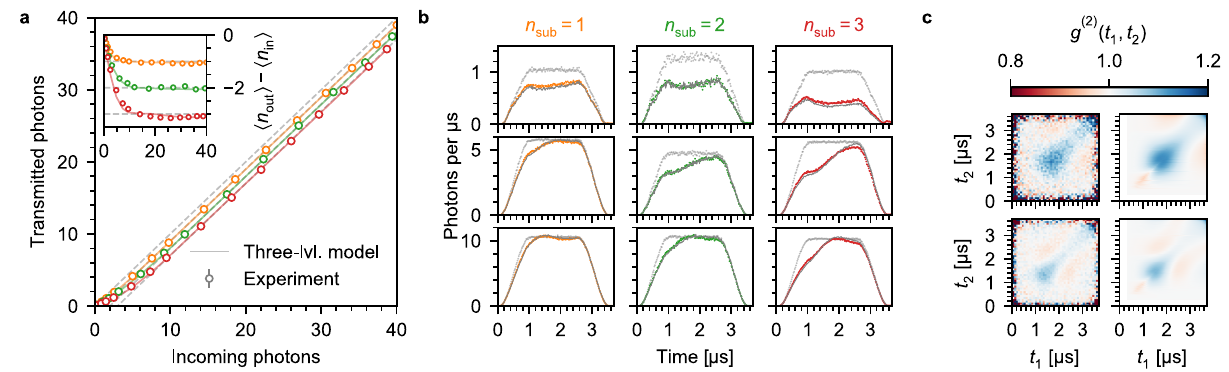
Fig. 2 Effect of one, two and three single-photon absorbers on the probe transmission. a Mean transmitted photons vs. mean incoming photon number. The inset shows the mean subtracted photons for the same data. All data are corrected for off-resonant absorption of the probe light and background counts. Error bars correspond to one standard error and are smaller than the markers for most data points. b Temporal pro fi les of probe light following transmission through n sub = 1 (left), 2 (centre) and 3 (right) absorbers for different mean photon numbers. The incoming pulses recorded in the absence of the superatom absorbers are shown in light grey. Besides the experimental data, we also show the results of the three-level model fi tted to the experimental data (dark grey). c . Photon correlations following transmission through three superatom absorbers. Second-order correlation functions g (2) ( t 1 , t 2 ) for R in ≈ 5.5 (top) and 10 μ s − 1 (bottom). Besides the experimental data (left), we also show the predictions of the three-level